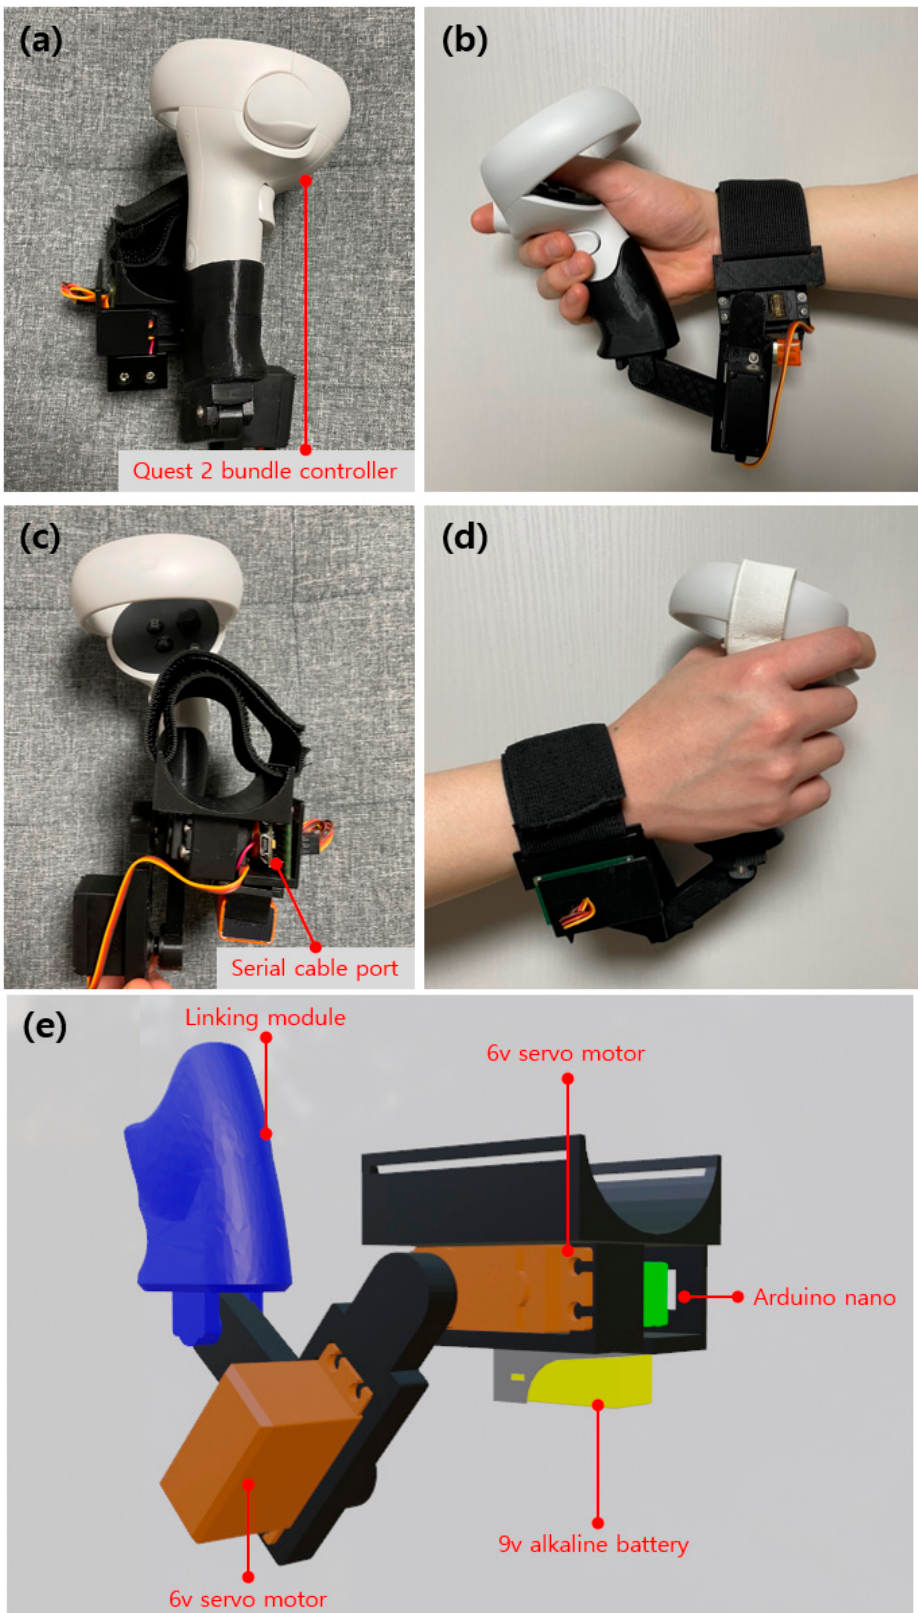
Figure 2. Shape of the prototype device connected to the controller: ( a ) front view; ( b ) back view; ( c ) side view 1; ( d ) side view 2; ( e ) 3D model.